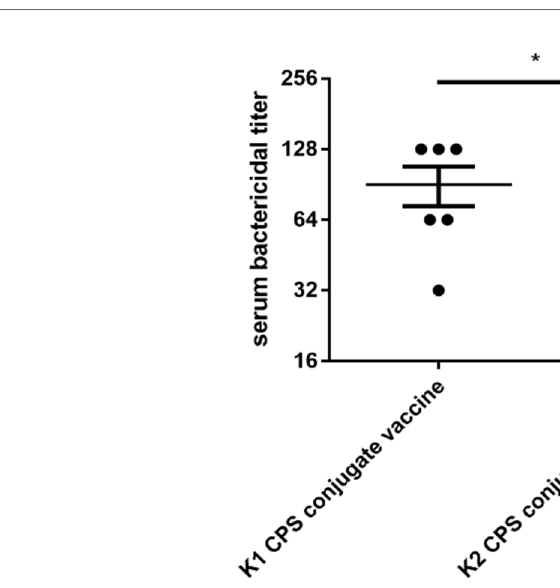
FIGURE 5 | The bactericidal titers of serum from mice administered with K1 or K2 CPS-conjugated vaccines. The data were analyzed using the two-tailed unpaired t test. * P <